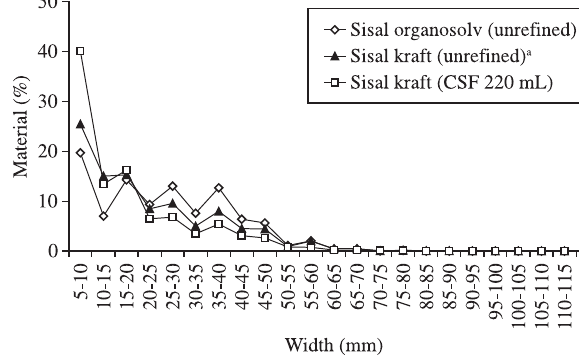
Figure 2. Results of chemical characterization of organosolv pulps at dif- ferent pulping times.